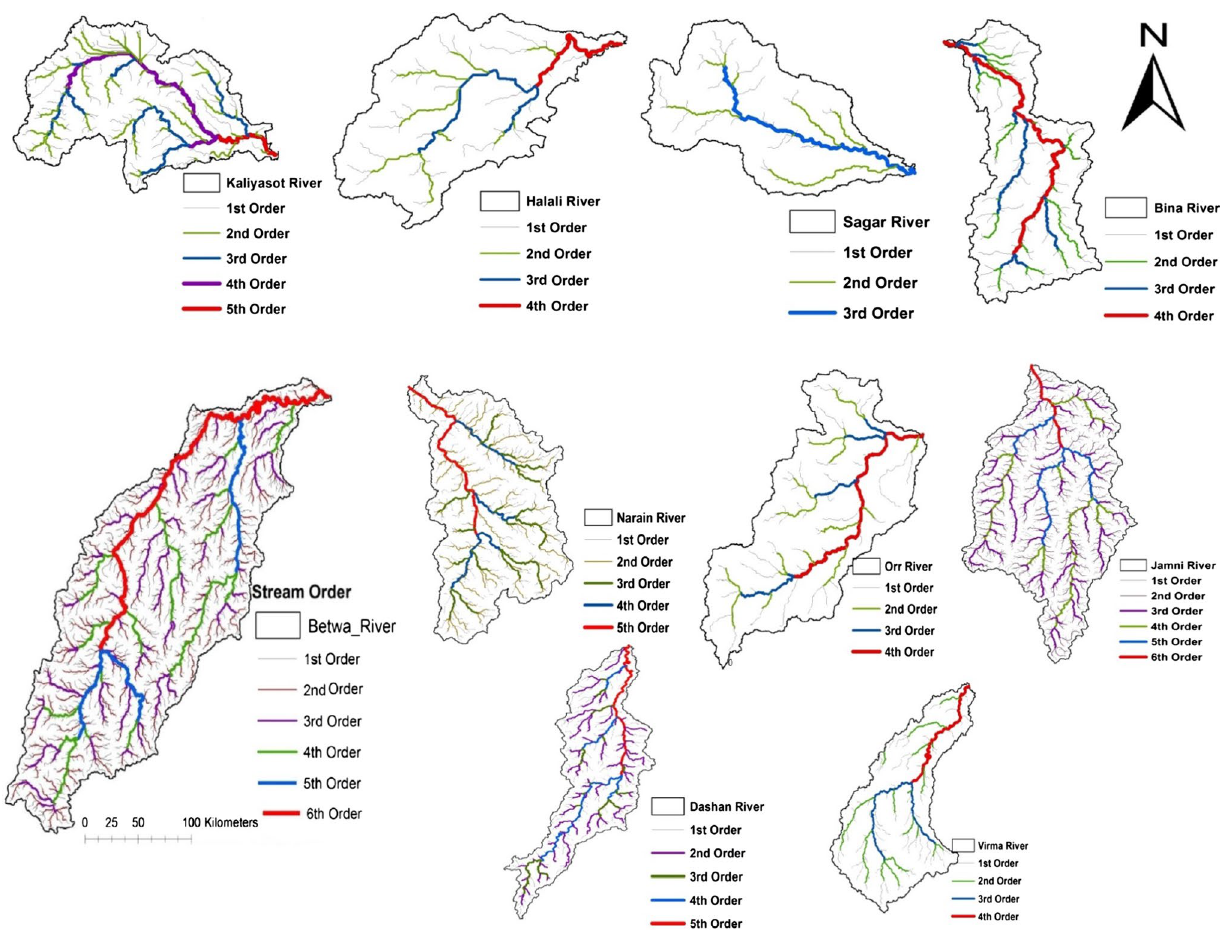
Fig. 3 Drainage and stream order map of the Betwa River basin and sub-basins